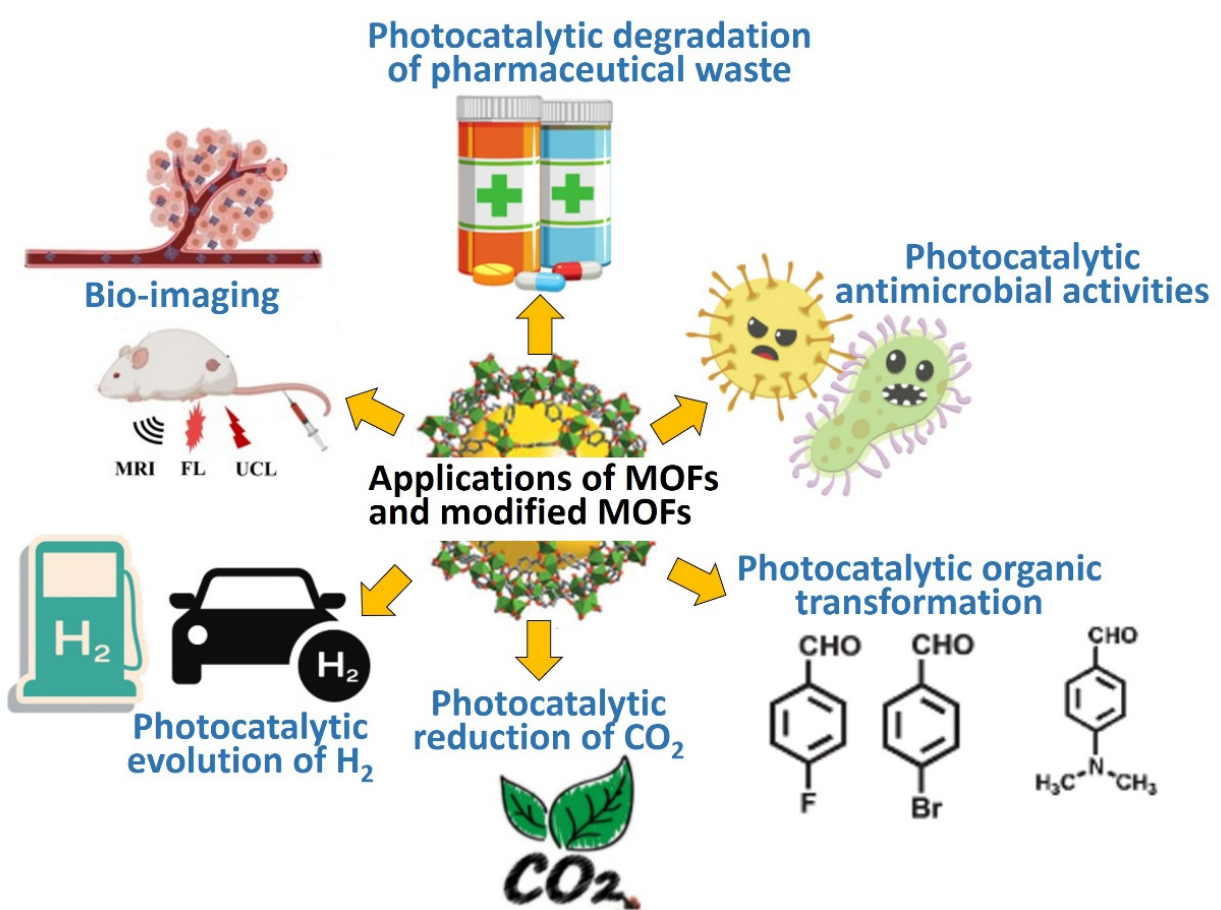
Figure 2. Different applications of MOFs and MOFs-based heterostructures.